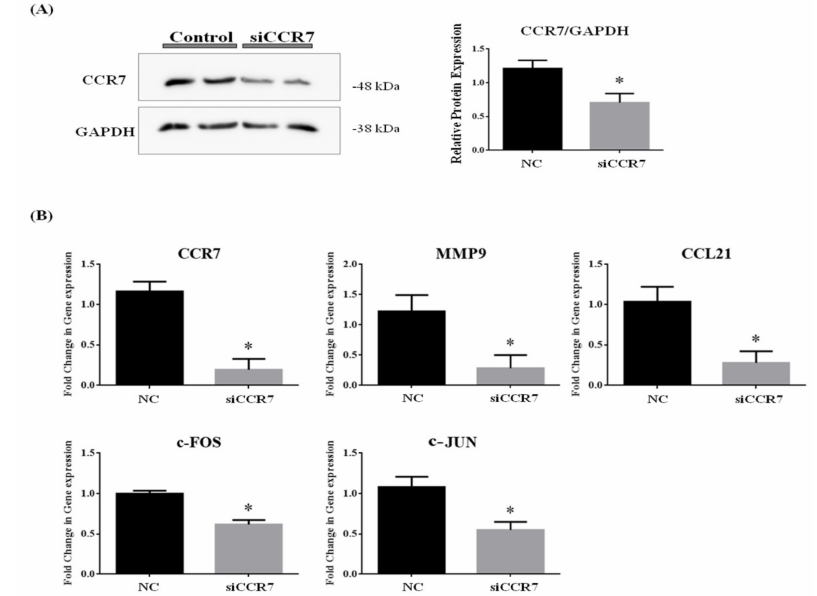
Figure 6. Downregulation of CCR7 gene by siRNA inhibits gene expression of MMP9, c-FOS, c-JUN and CCL21 in vitro. ( A ) Western blot of proteins extracted from MCF7 cell against CCR7 and GAPDH. ( B ) To investigate level of transcripts associated with CCR7, MMP9, CCR7, c-FOS, c-JUN and CCL21 were monitored in MCF7 cell transfected with CCR7 siRNA by using qPCR. B-ACTIN and 18S mRNA was used as an internal control in real time PCR. Data are representative of four independent experiments and are expressed as the mean ± SD; * p < 0.05 vs. negative